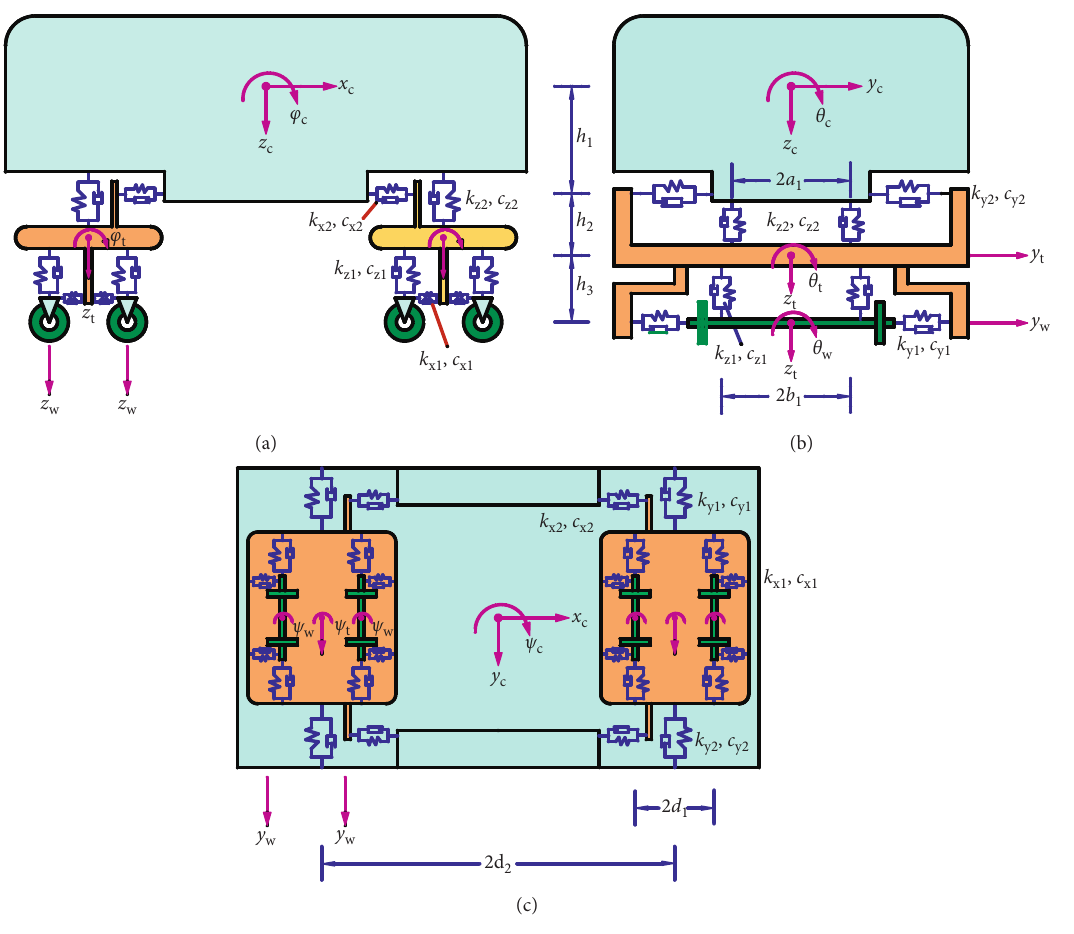
Figure 2: Side, bottom, and rear view of the vehicle model exhibiting 35 DOFs.